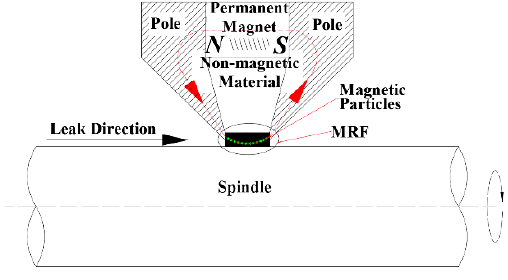
Figure 1. MR fluid sealing device.